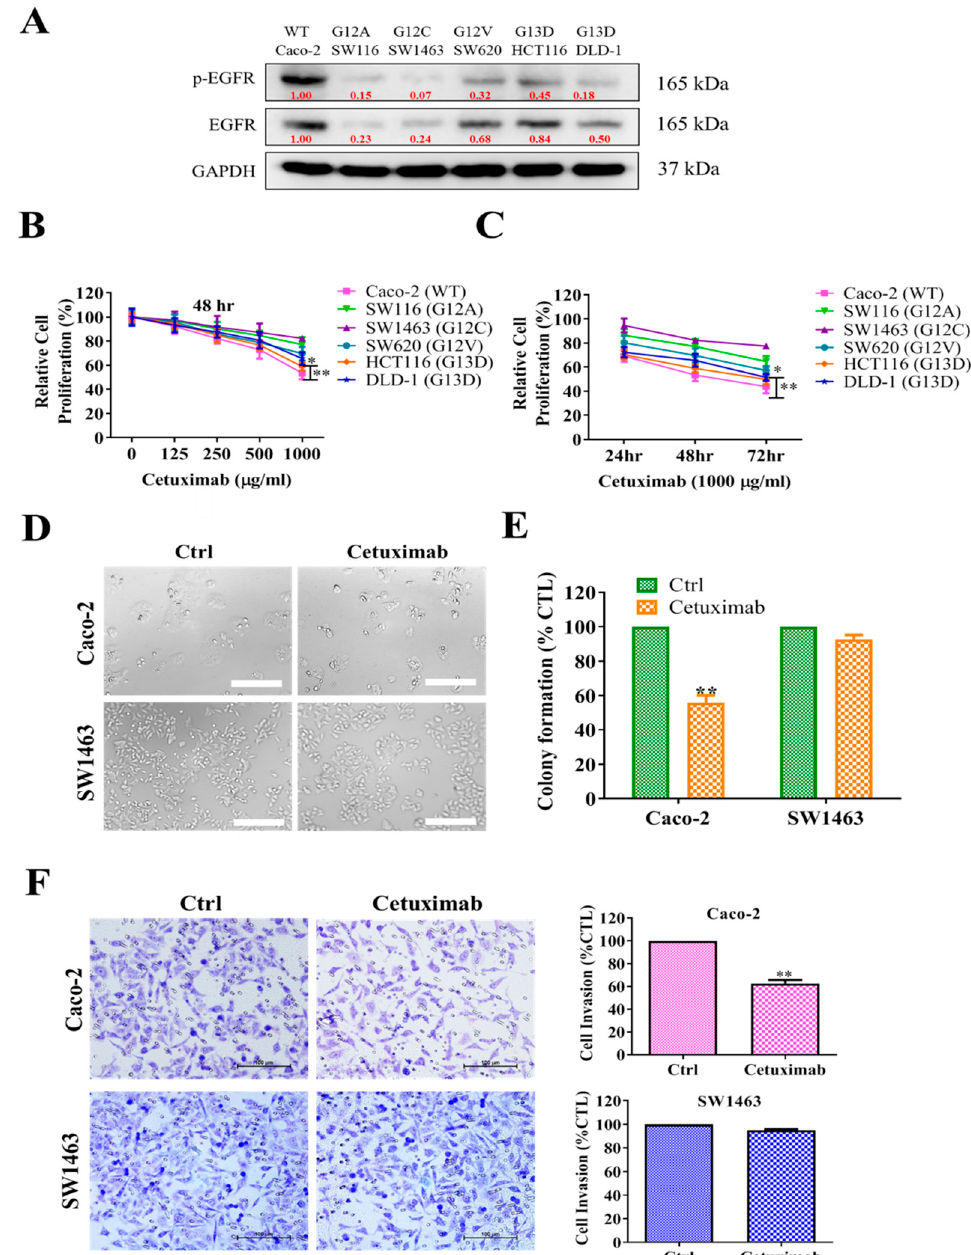
Figure 2. KRAS-mutated CRC cells resist cetuximab treatment. ( A ) Western blot analysis of expression of p-EGFR/EGFR in CRC cells. ( B,C ) Cell proliferation analysis by using sulforhodamine B (SRB) assay of KRAS-wild (Caco-2) and KRAS-mutant CRC cell lines. The graphic represents the dose-dependent and time-dependent effect of cetuximab on the relative cell proliferation of CRC cells in relation to controls. ( D ) Effect of cetuximab on CRC cell morphology as obtained through phase-contrast microscopy image at 200 × magnification. ( E , F ) Colony formation assay and invasion assay of cetuximab treated and non-treated (control) cells. Representative figures and quantification of the covered areas by using ImageJ are provided in D and F, respectively. * p < 0.05, ** p < 0.01; scale bar 100 µ